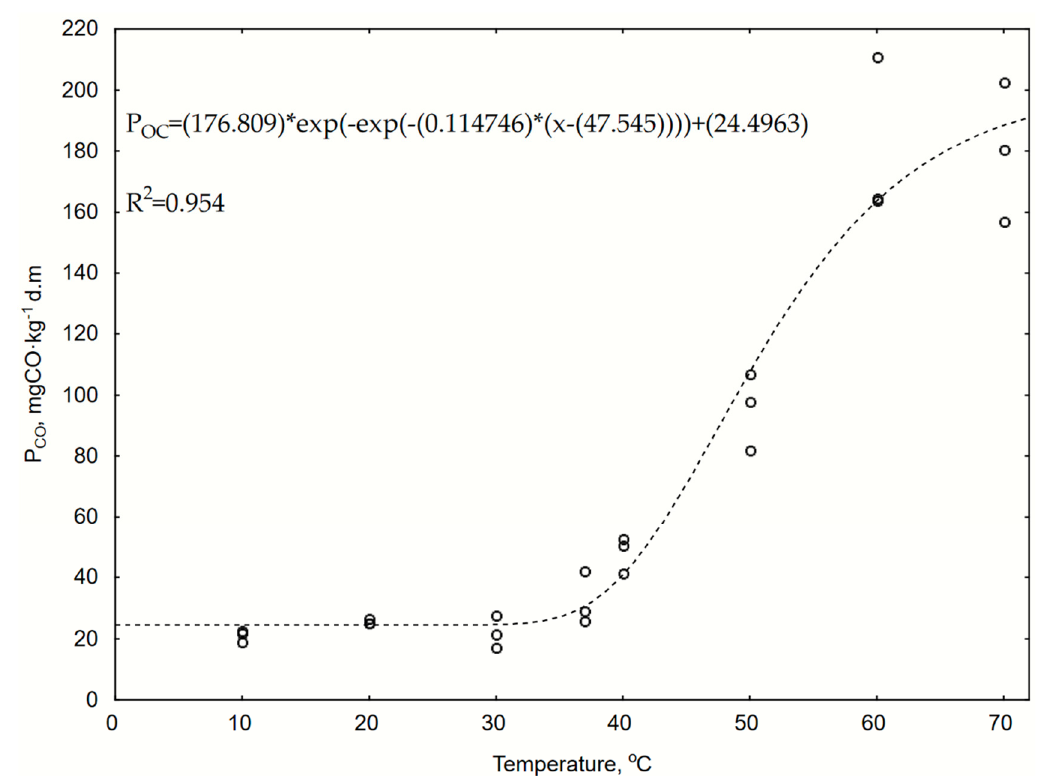
Figure 4. The influence of the composting temperature ( T ) on CO production potential ( P CO ).